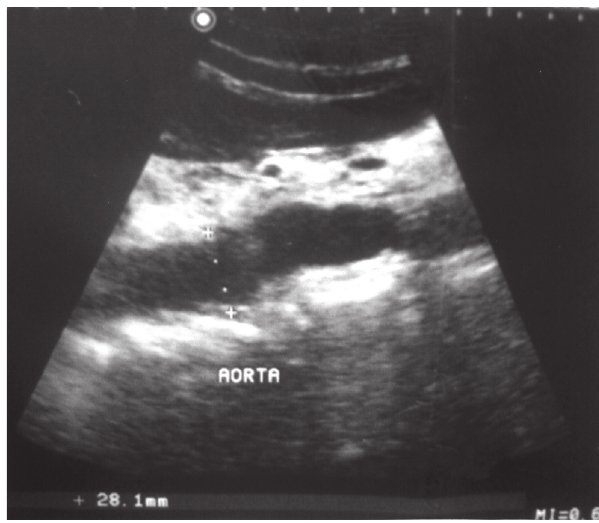
Figure 3 - Ultrasonographic longitudinal imaging of an abdominal aortic